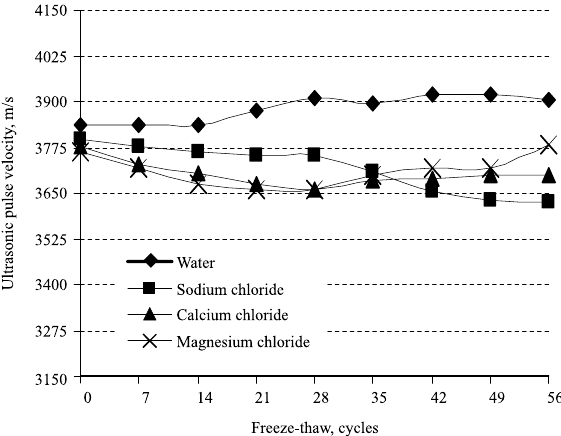
Fig. 4. Kinetics of ultrasonic pulse velocity in specimens made of Portland cement with NST additive after 56 freeze-thaw cycles in different saline